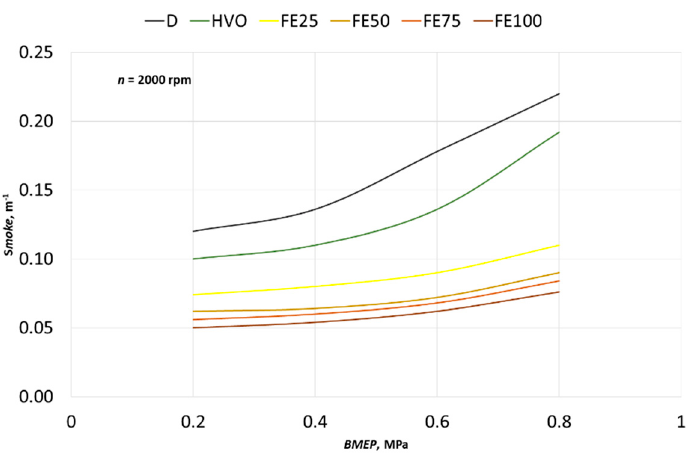
Figure 12. Dependence of smoke emissions on the load. Should be replaced by smoke.